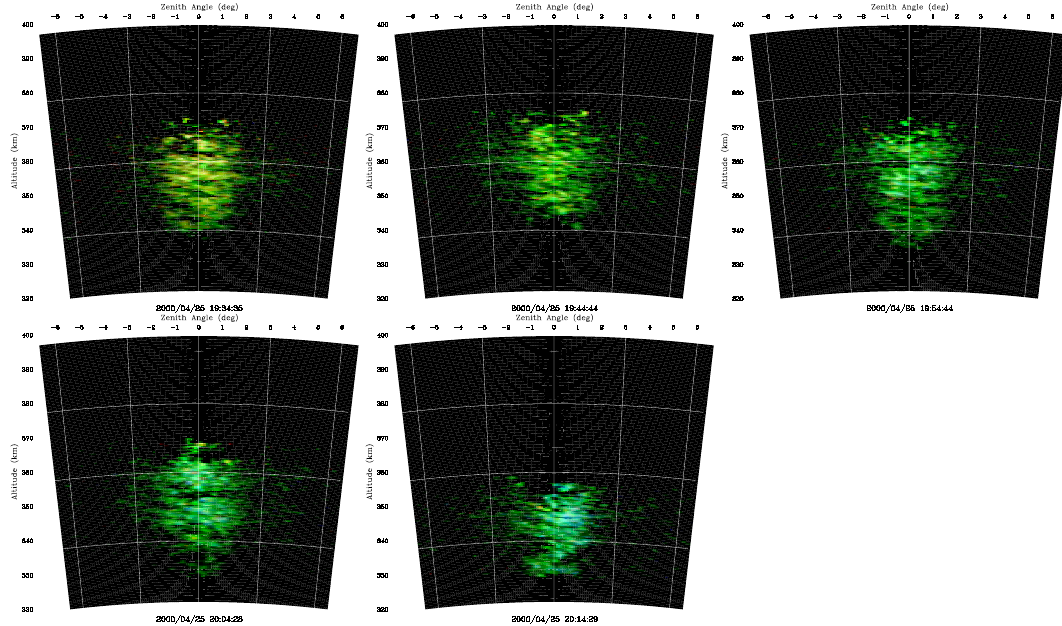
Fig. 3. Aperture synthesis images of the bottom-type layer observed on 25 April 2000 at five local times. Pixel brightness represents the signal-to-noise ratio on a scale from